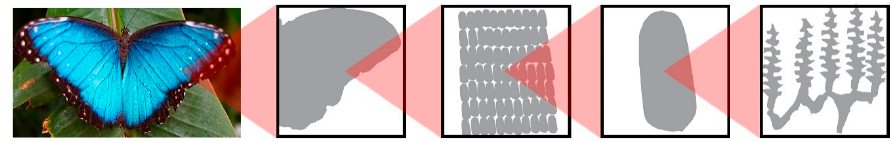
Figure 7. Heterogeneity in a conventional roof structure showing the heterogeneous forms of the roof and eaves.